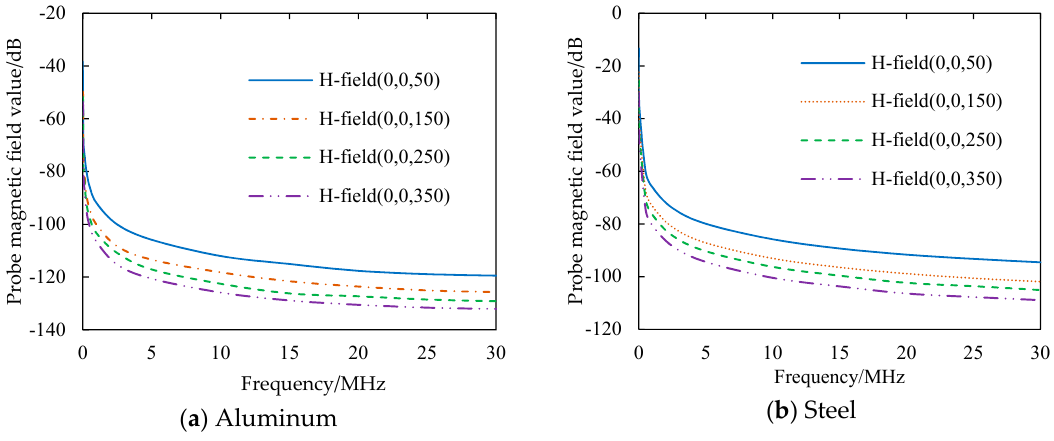
Figure 8. The attenuation value of the magnetic field on the probes.